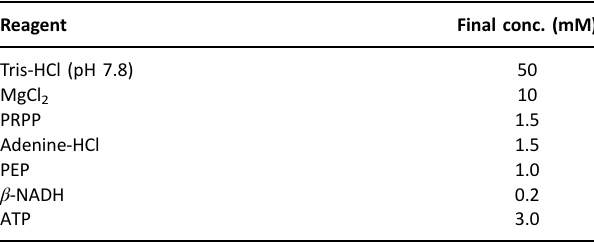
Table 7. Reagents for APRT assay.